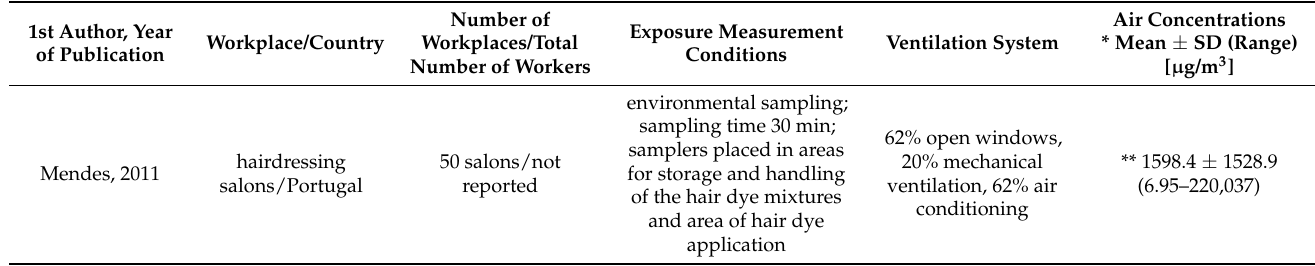
Table 2. Summary of studies reporting ammonia air concentrations ( n =